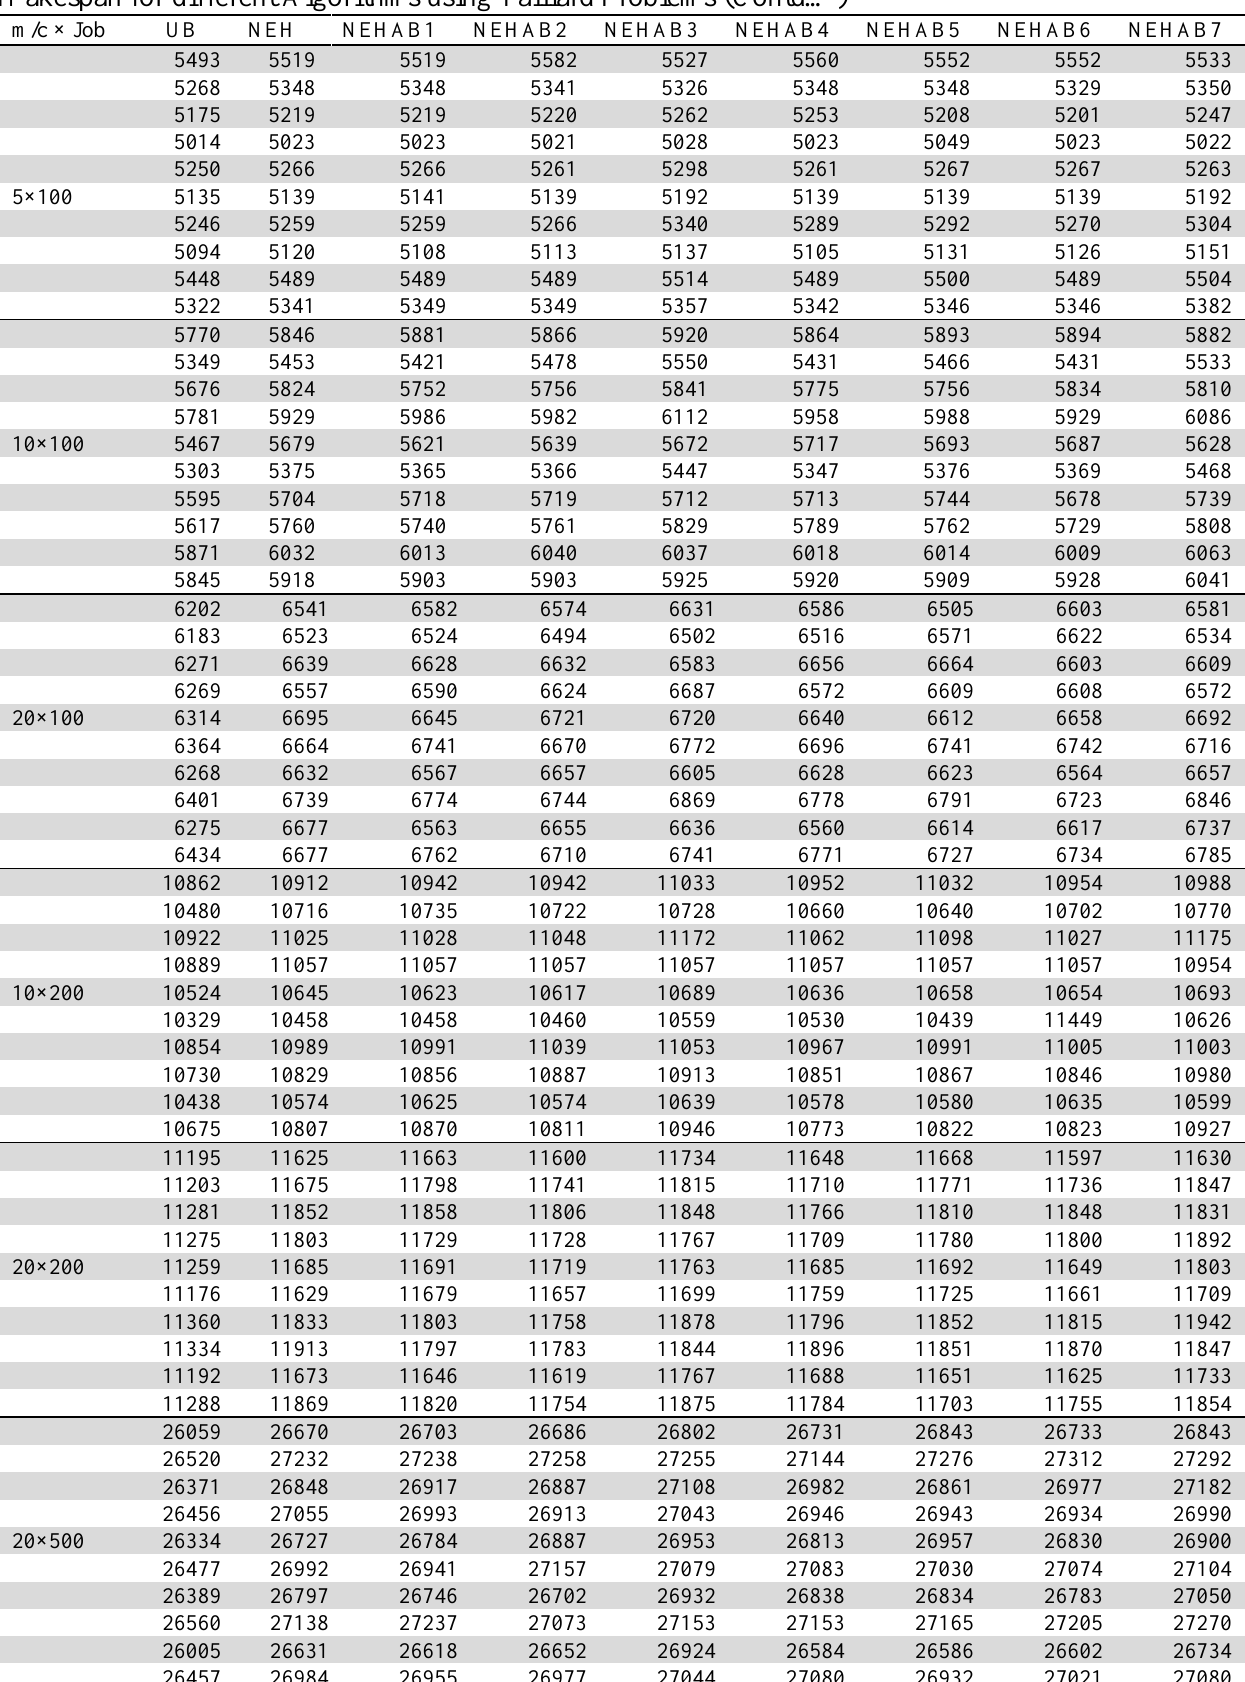
Makespan for different Algorithms using Taillard Problems (Contd…) m/c ×